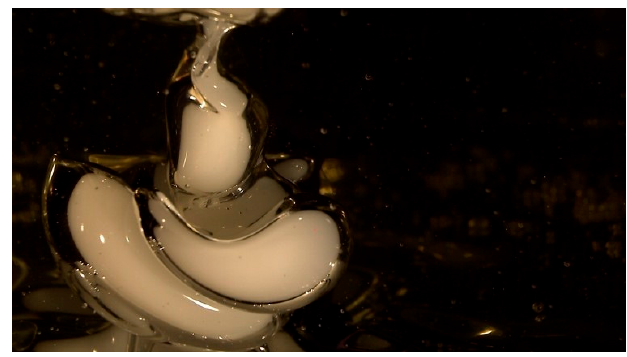
Figure 13. Bubbles generated by dry ice.